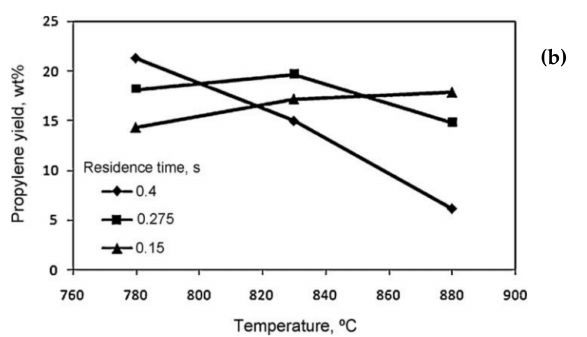
Figure 10. ( a ) Effect of residence time on the product yields [42], ( b ) effect of residence time on the propylene yield (steam-to-oil ratio = 0.5 g/g) [48].